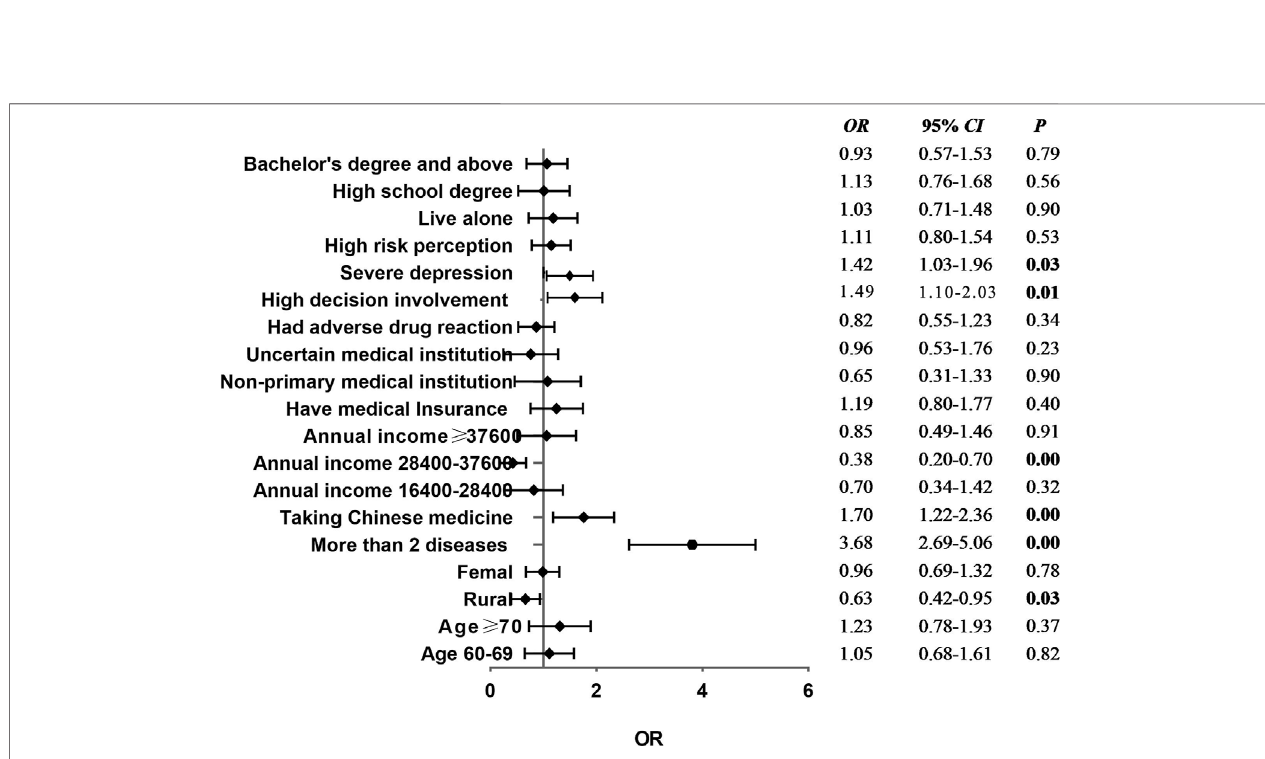
FIGURE 2 | Forest plot of logistic regression analysis results of polypharmacy after matching.